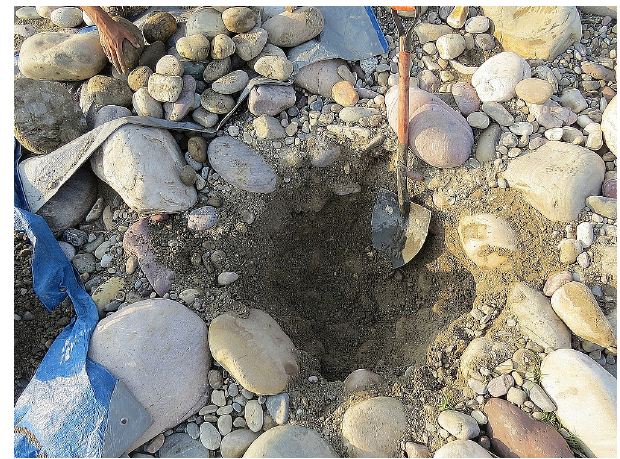
Figure A9. RAEM – sieved from upper layer of modern gravel bar.